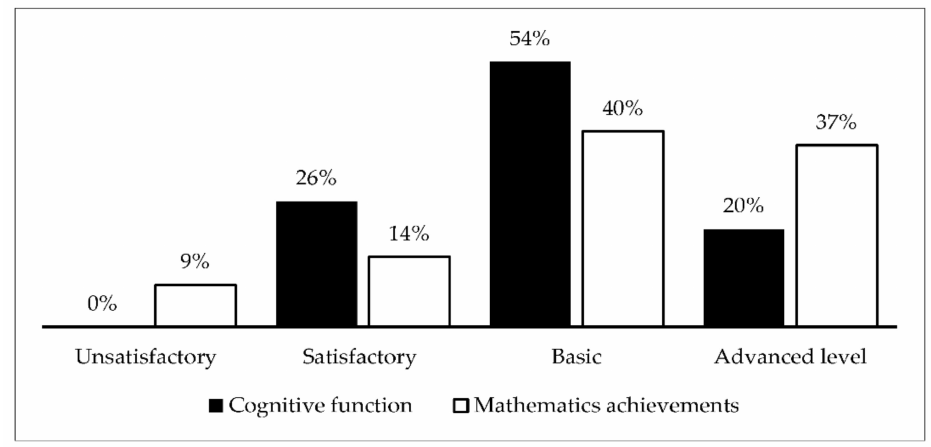
Figure 1. Achievements in mathematics and cognitive function of primary school students.